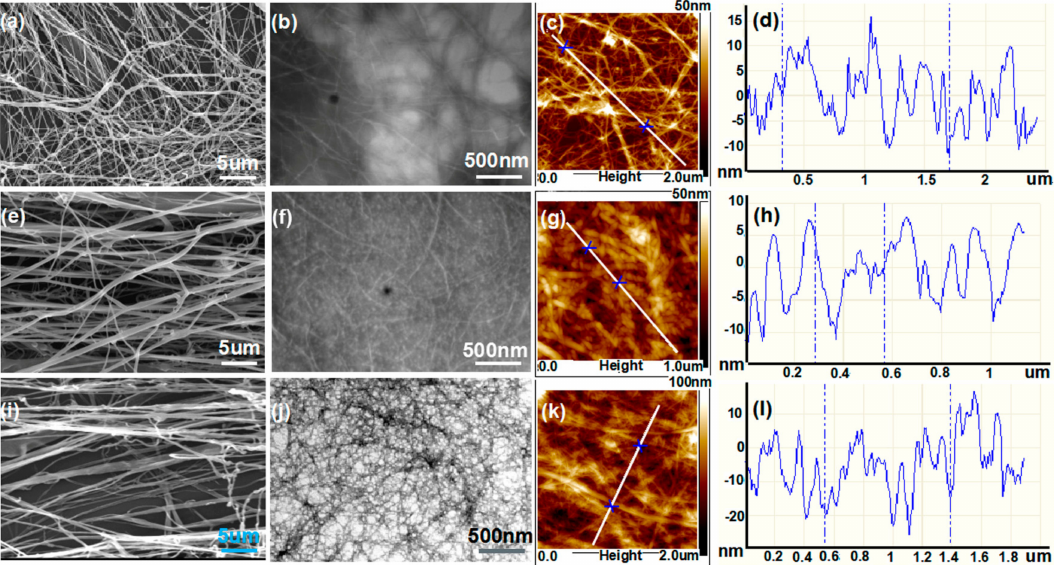
Figure 2. Morphology of nanocellulose derived from three di ff erent biomass resources: ( a–d ) from the shrub branch: ( a ) SEM morphology, ( b ) TEM image, ( c ) AFM image, and ( d ) the diameter distribution of the fibers from the AFM image; ( e – h ) from wheat straw: ( e ) SEM morphology, ( f ) TEM image, ( g ) AFM image, and ( h ) the diameter distribution of the fibers from the AFM image; ( i – l ) from poplar residue: ( i ) SEM morphology, ( j ) TEM image, ( k ) AFM image, and ( l ) the diameter distribution of the fibers from the AFM